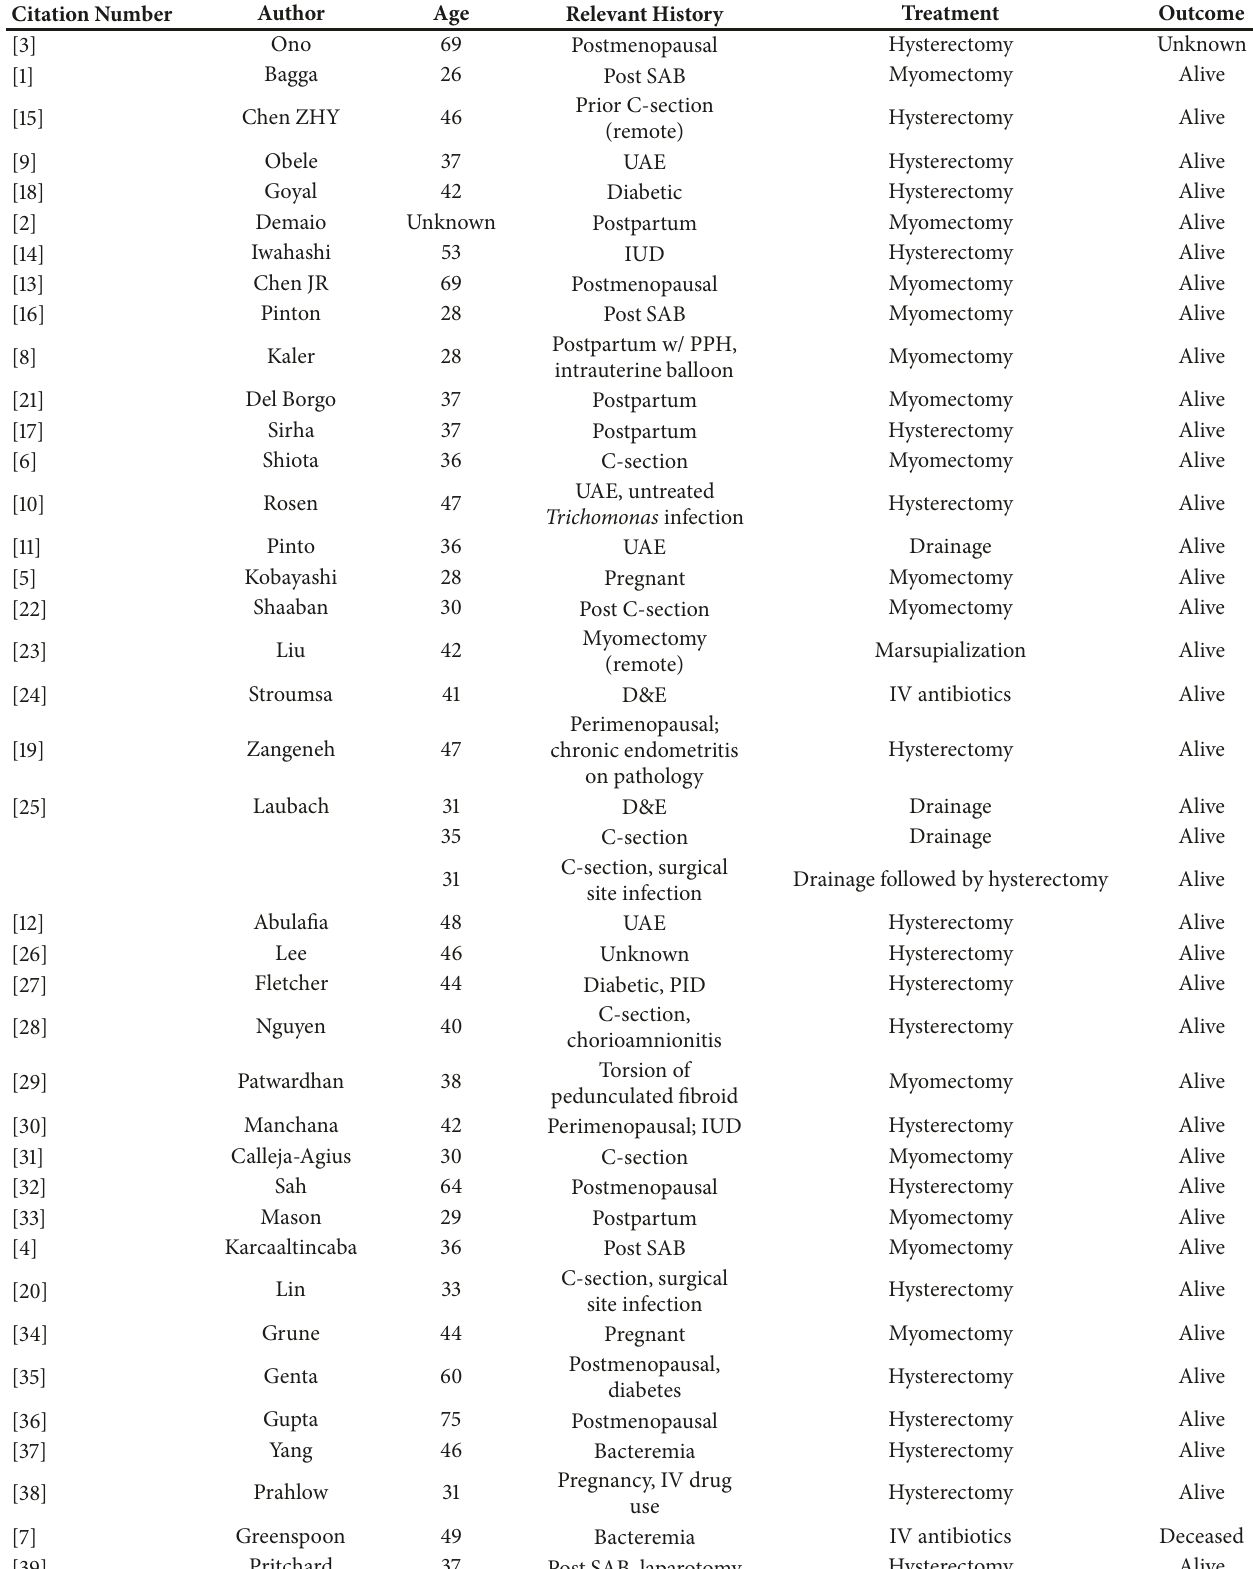
Table 1: List of reviewed